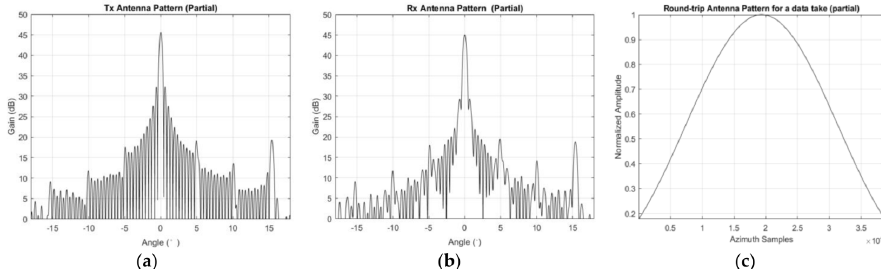
Figure 4. GF-3 azimuth antenna pattern of the data acquired in this experiment. ( a ) The antenna pattern within [ − 18 ◦ ,18 ◦ ] in transmit mode; ( b ) The antenna pattern within [ − 18 ◦ ,18 ◦ ] in receive mode; ( c ) The interpolated round-trip antenna